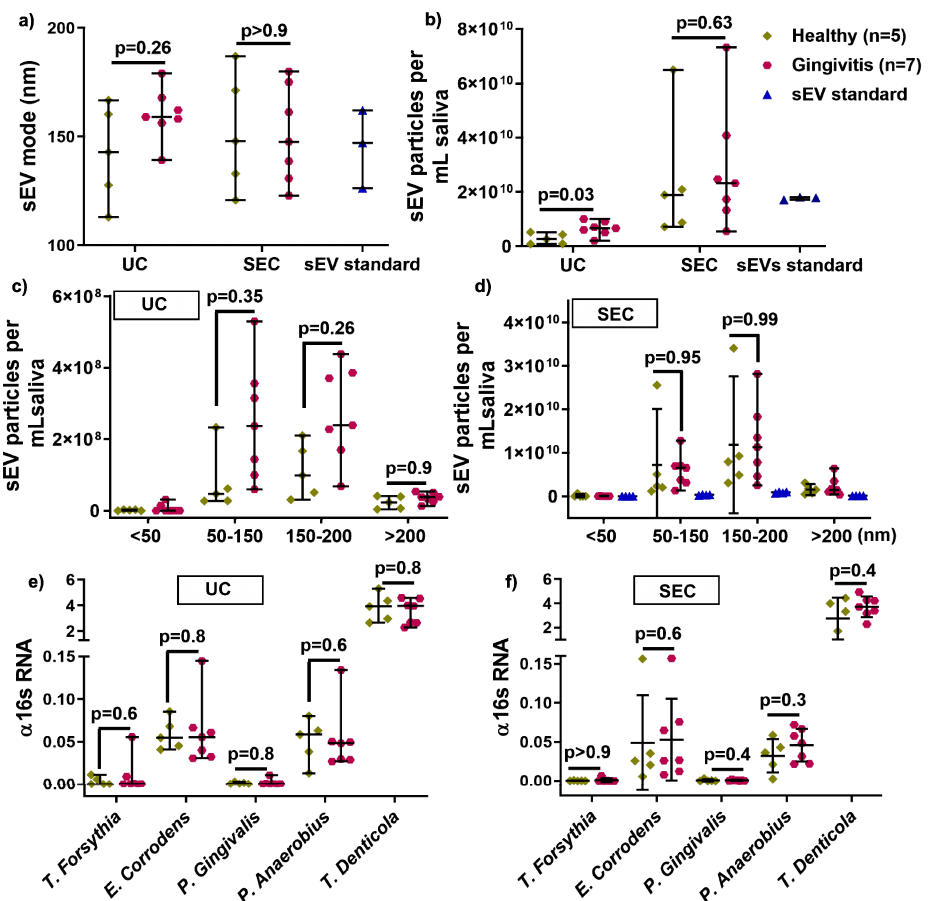
Figure 3. The influence of UC and SEC method on healthy and gingivitis sEV characteristics, such as size ( a ), particle concentration in per mL saliva ( b ), size distribution ( c , d ), and periodontal pathogen OMVs ( e , f ).